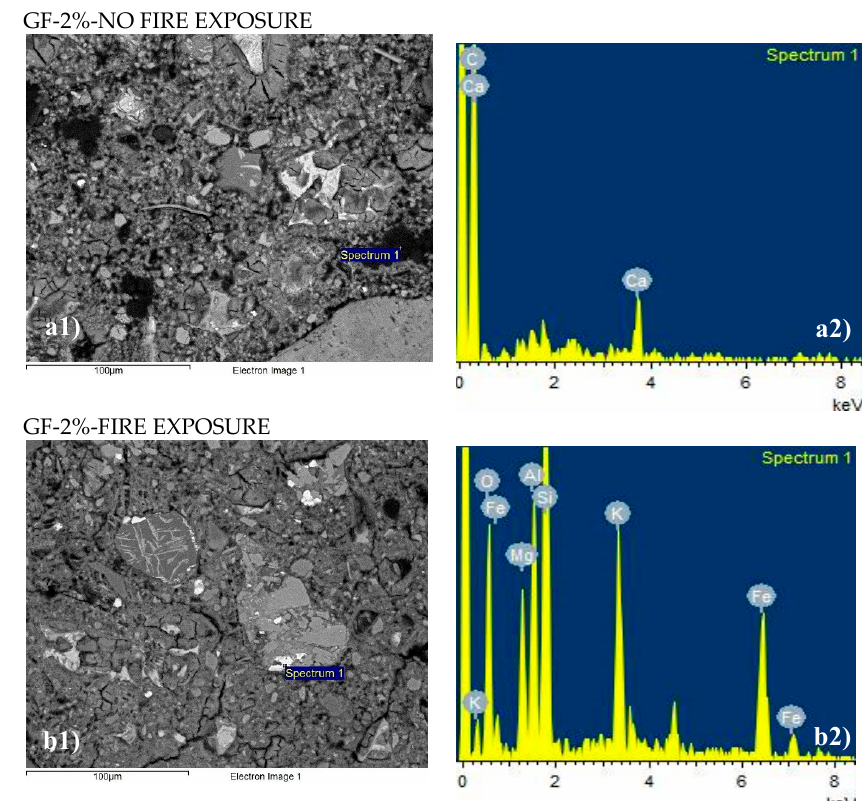
Figure 12. Energy dispersive x-ray microanalysis at 500 magnifications of thin-layer test pieces containing 2% of CNFs. ( a ) Before thermal aggression; ( b ) After thermal aggression.